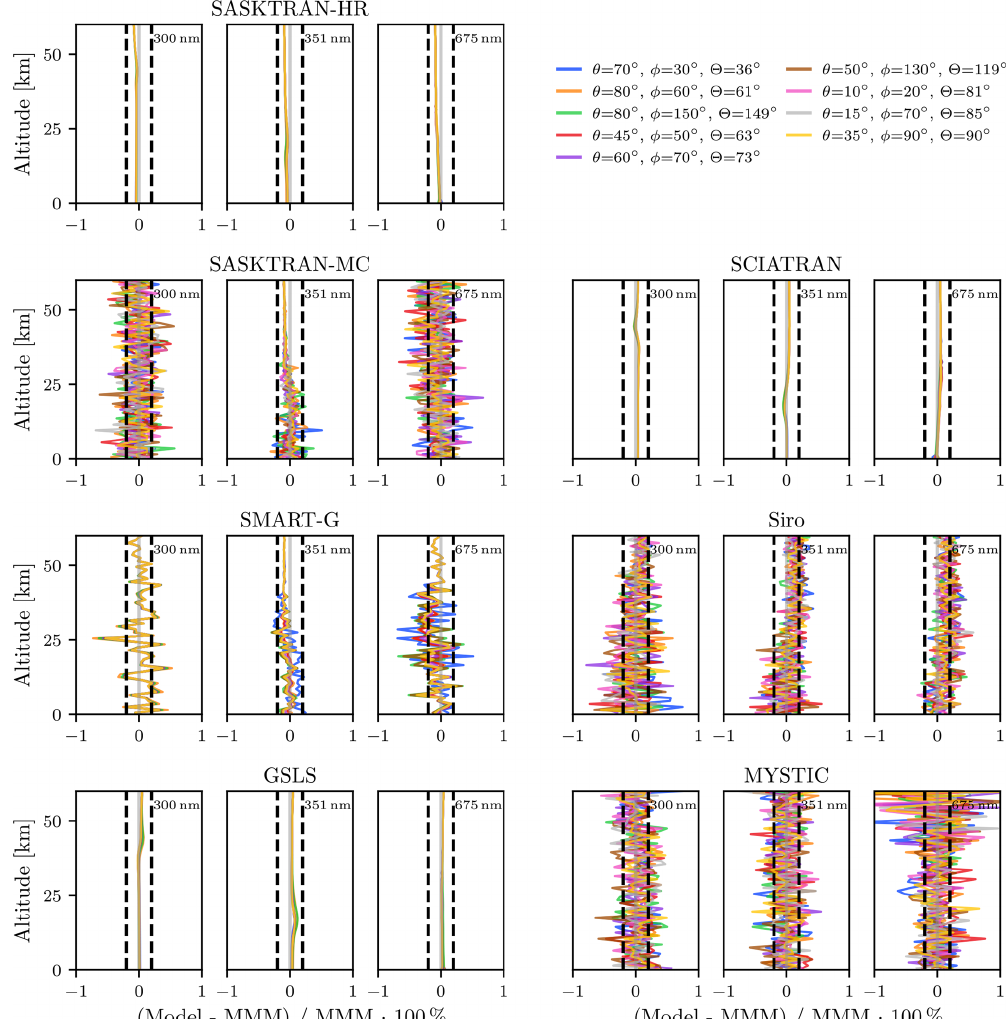
Figure 3. Percent differences in single scatter I relative to the MMM (GSLS, SASKTRAN-HR, and SCIATRAN) for each RTM at a variety of wavelengths and solar conditions. The atmospheric optical properties include Rayleigh scattering, ozone absorption, and stratospheric aerosol Mie scattering. Refraction is disabled. Dashed vertical lines indicate ± 0 .